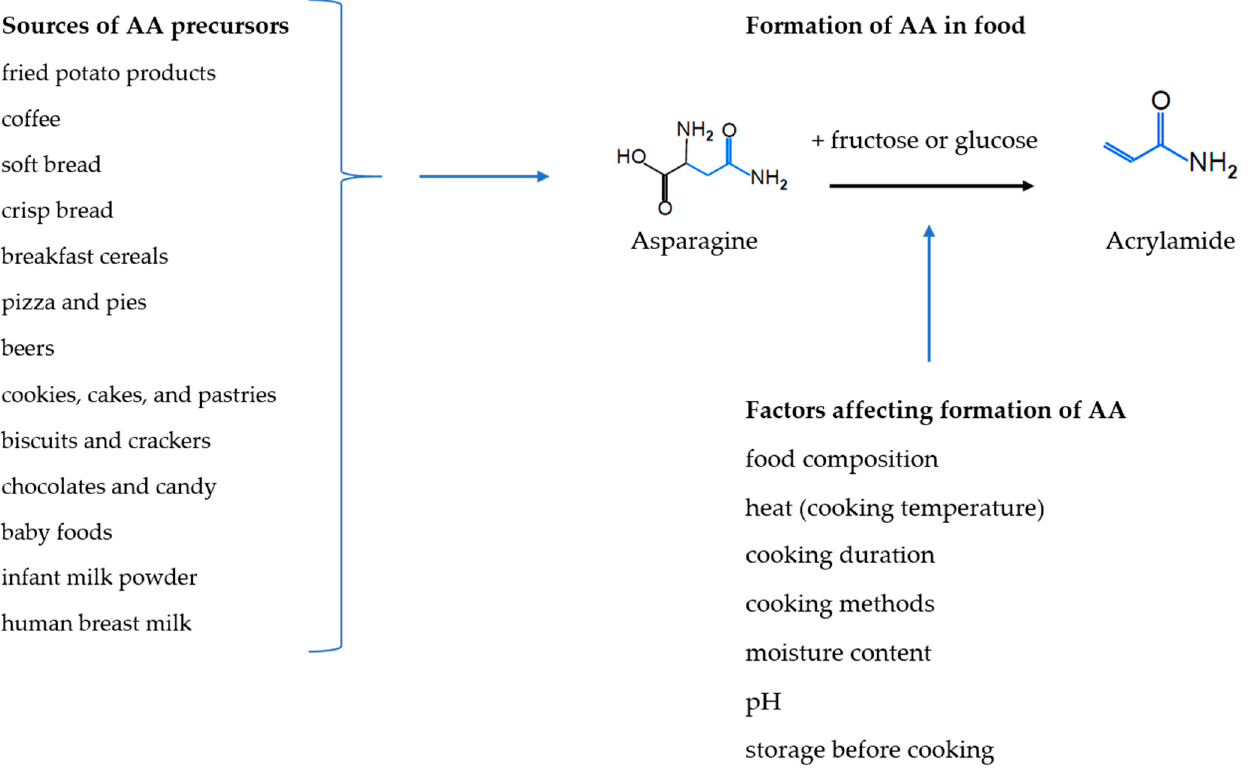
Figure 1. Sources, formation and factors affecting formation of acrylamide (AA).